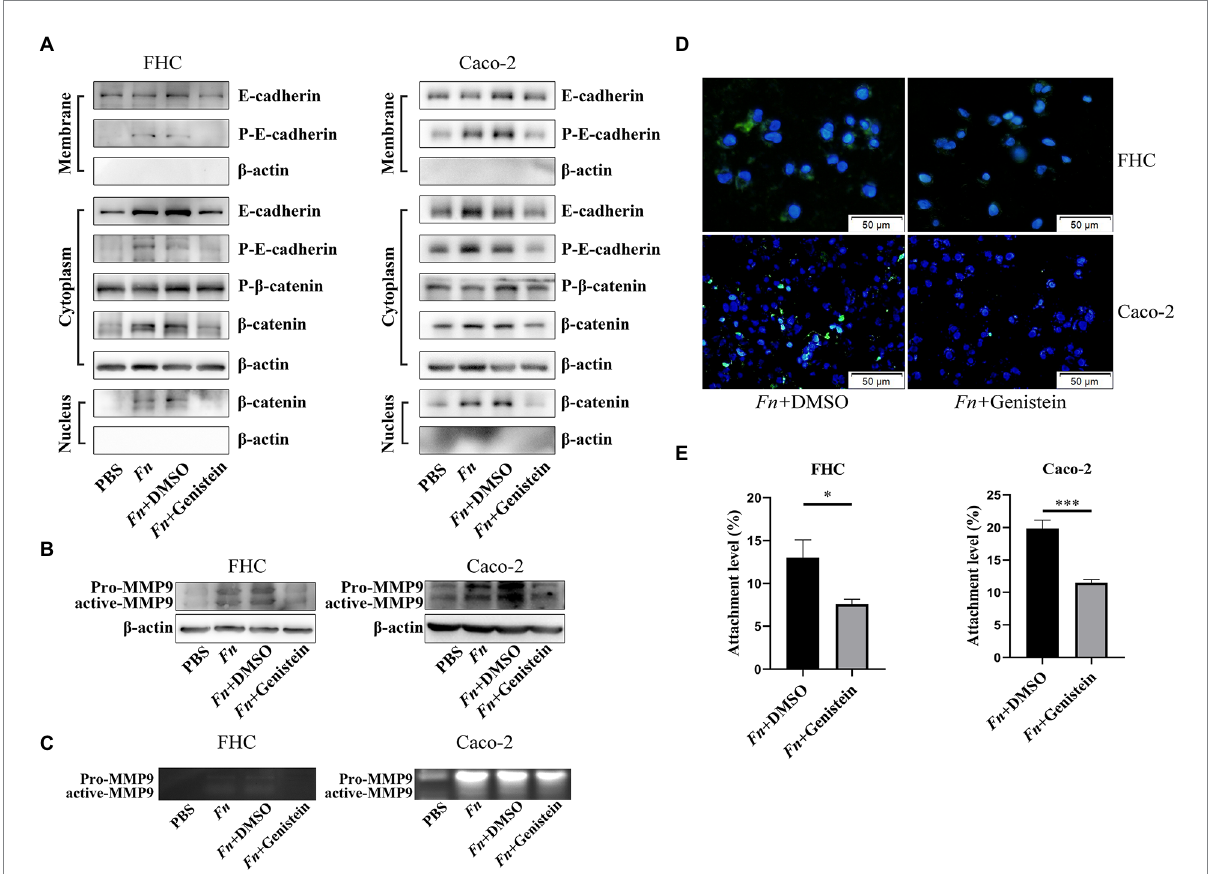
FIGURE 4 Fn promotes MMP9 expression of epithelial cells depending on the E-cadherin/ β -catenin signaling. (A,B) The protein expression level of E-cadherin, β -catenin, and MMP9 in epithelial cells treated with PBS, Fn , Fn + genistein, and Fn + DMSO, respectively. (C) Gelatin zymography of four groups conditioned medium. (D) The amount of FITC-labeled Fn after genistein treatment (original magnification, 200×) (bar, 50 μ m). (E) Genistein inhibits Fn from attaching to epithelial cells. * p < 0.05, *** p <